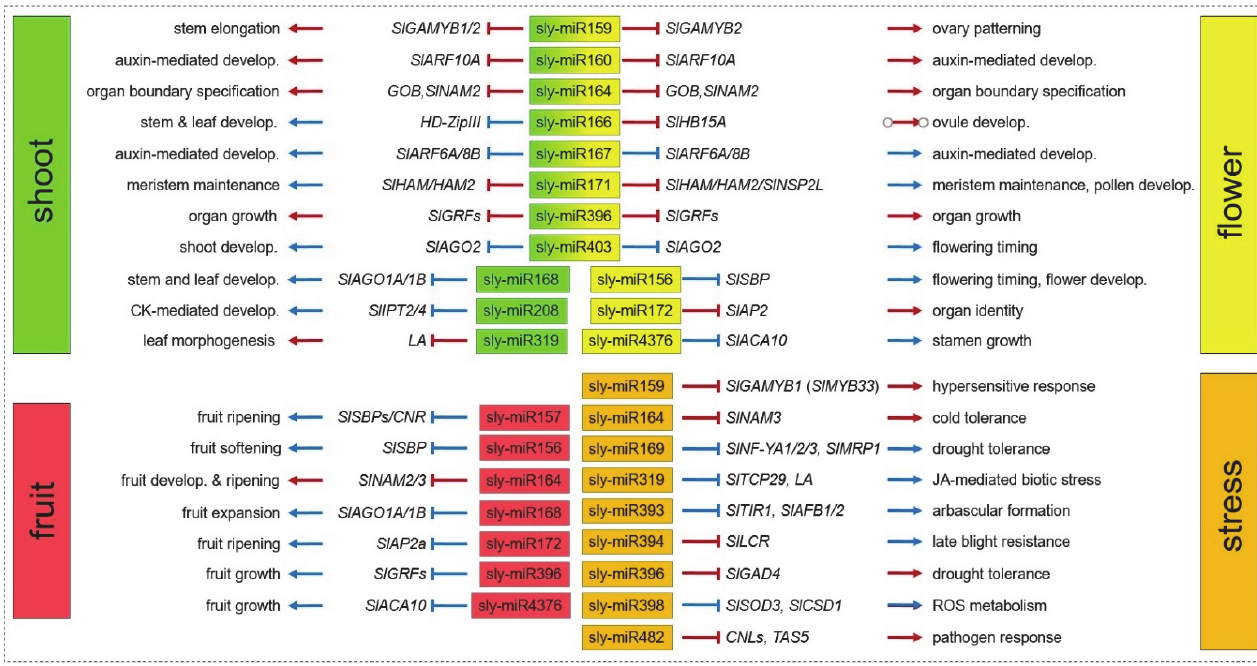
Figure 2. Tomato miRNAs, which were functionally analyzed, their target mRNAs, and the processes they regulate based on the reviewed publications. MiRNAs are color-coded based on their tissue or stress relevance. Red lines and arrows indicate biologically relevant targets and established functions. Blue lines and arrows indicate putative targets and suggested functions. Develop. indicates development.